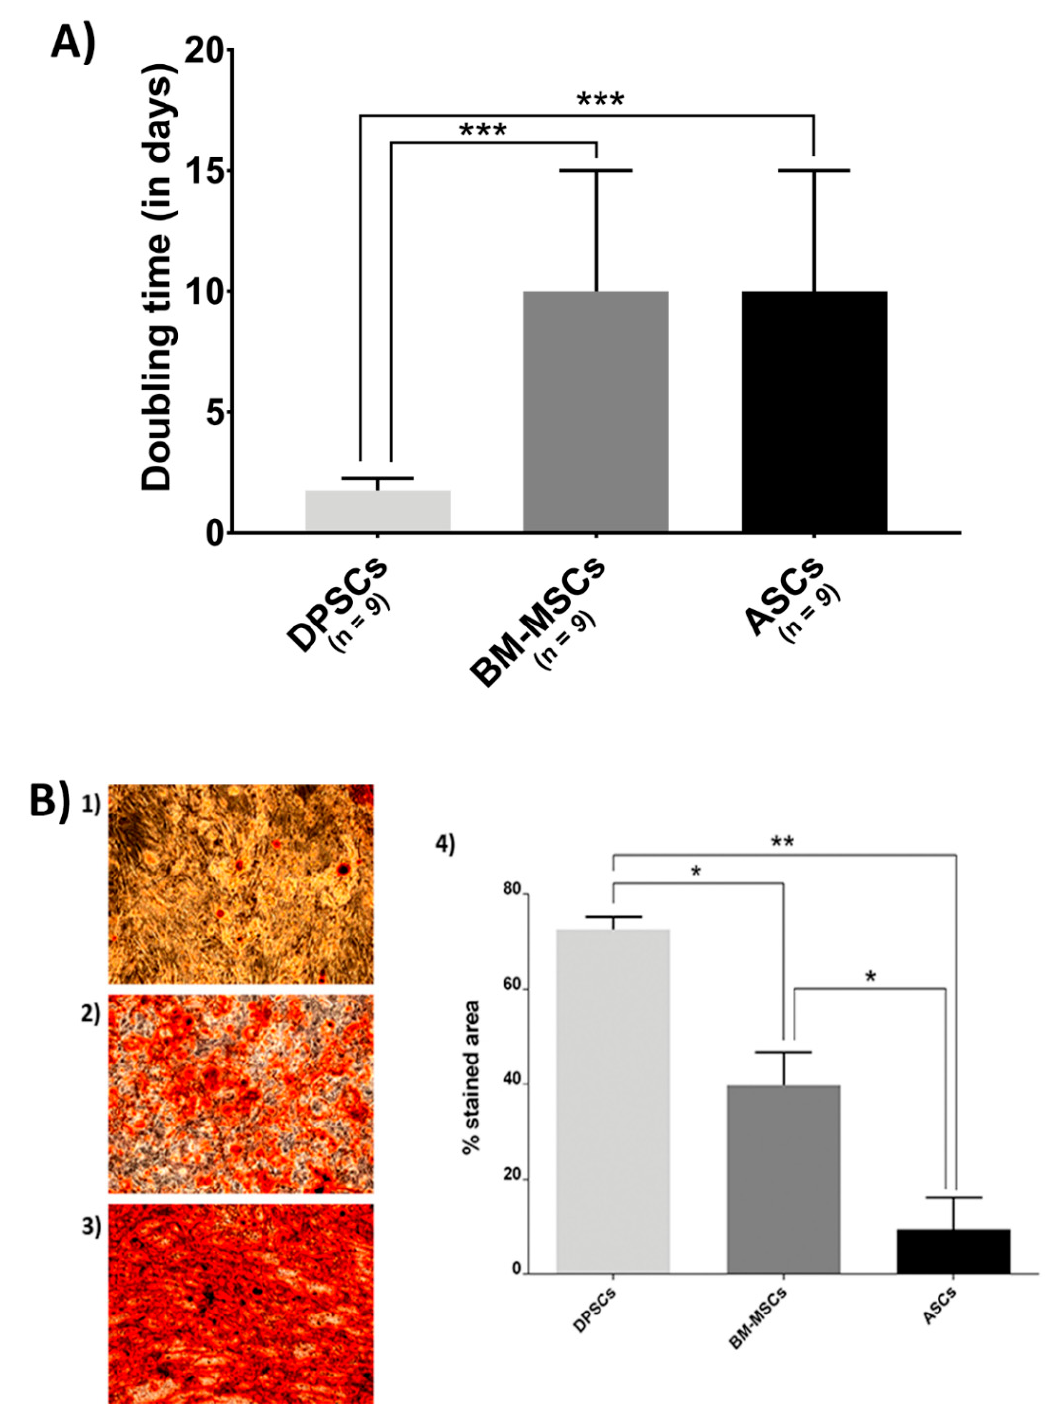
Figure 1. Biological features of MSCs on the plastic surface: ( A ) MSC proliferation. Doubling time (in days) when cultured in plastic presented by MSC isolated from adipose tissue (ASCs), dental pulp (DPSCs), and bone marrow (BM-MSCs); and ( B ) Alizarin Red staining and its quantification of different source-derived mesenchymal stem cells—(1) Alizarin Red staining of ASCs after 21 days of culture in osteogenic medium ( × 10); (2) Alizarin Red staining of BM-MSCs after 21 days of culture in osteogenic medium ( × 10); (3) Alizarin Red staining of DPSCs after 21 days of culture in osteogenic medium ( × 10); and (4) Alizarin Red staining quantification of MSC, according to the cell source, adipose tissue (ASCs), dental pulp (DPSCs), and bone marrow (BM-MSCs). All data are shown as mean ± standard deviation. Significance level: * p ≤ 0.05, ** p ≤ 0.01 *** p ≤ 0.001.